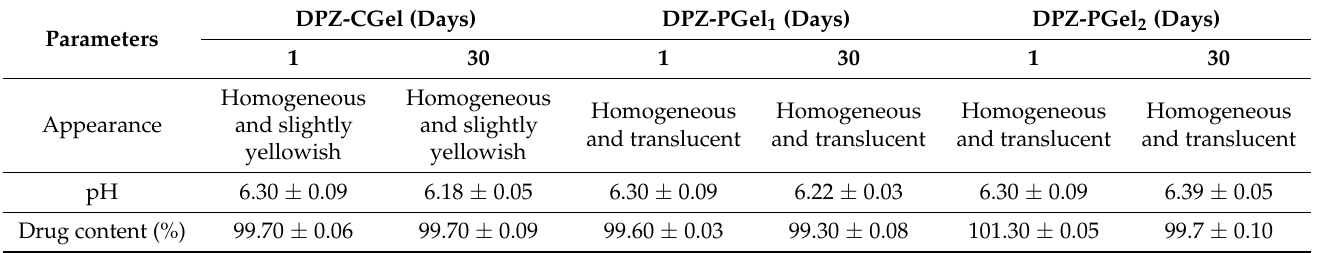
Table 3. Stability studies of chitosan and Pluronic F-127 formulations at 25 ± 2 ◦ C/65 ± 5% RH.